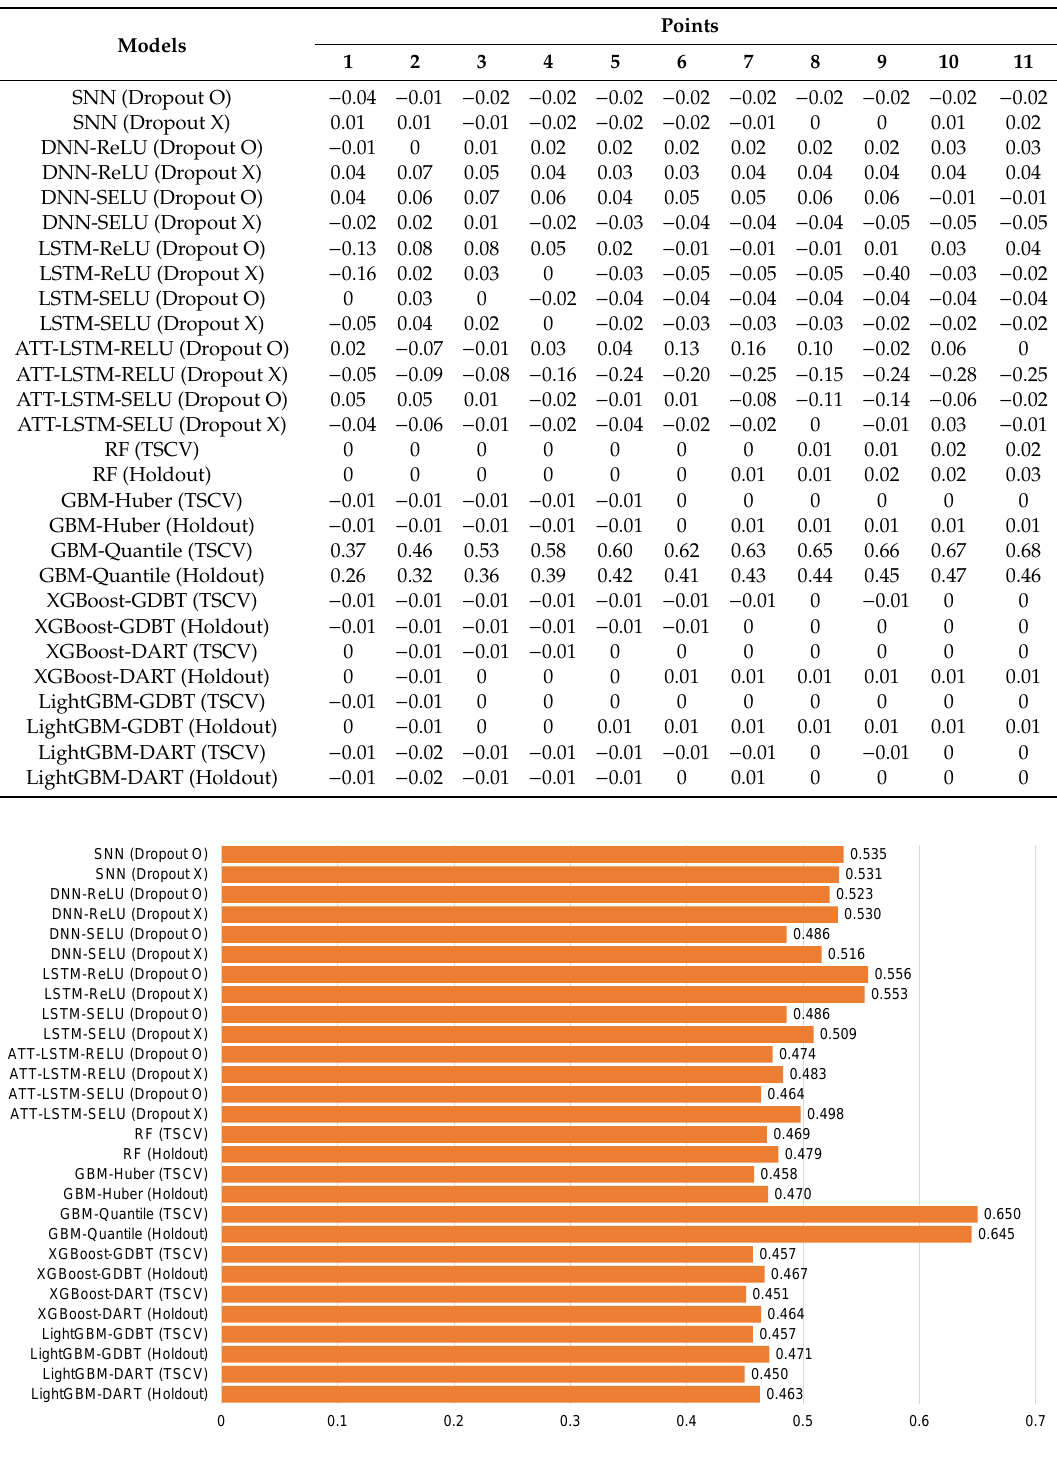
Figure 8. Average root mean square error for each model of Ildo-1 ( MJ/m ).